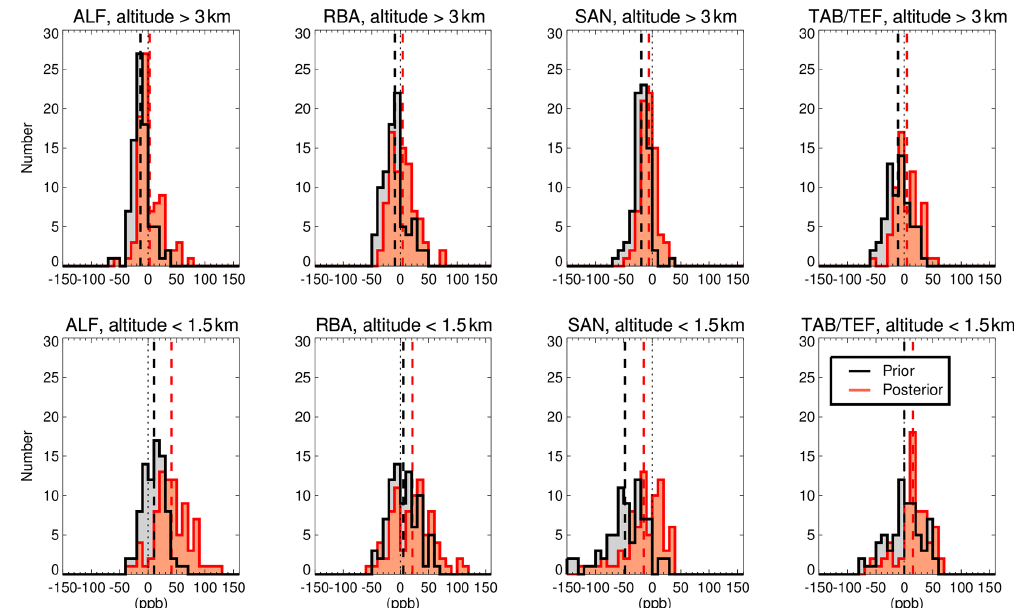
Figure 6. Histogram plots showing prior (black) and posterior (red) (model–observation) differences at the four Amazon flight locations, 2010–2018. Measurements were taken at Alta Floresta (ALF), Rio Branco (RBA), Santarém (SAN), and Tabatinga and Tefé (TAB/TEF). Model output has been interpolated to observation locations and altitudes, before both were averaged into monthly means and into altitude bins of 3km and above (a–d) and 1.5km and below (e–h) . Dotted vertical lines show the zero line, whilst dashed vertical lines show prior and posterior mean model–observation